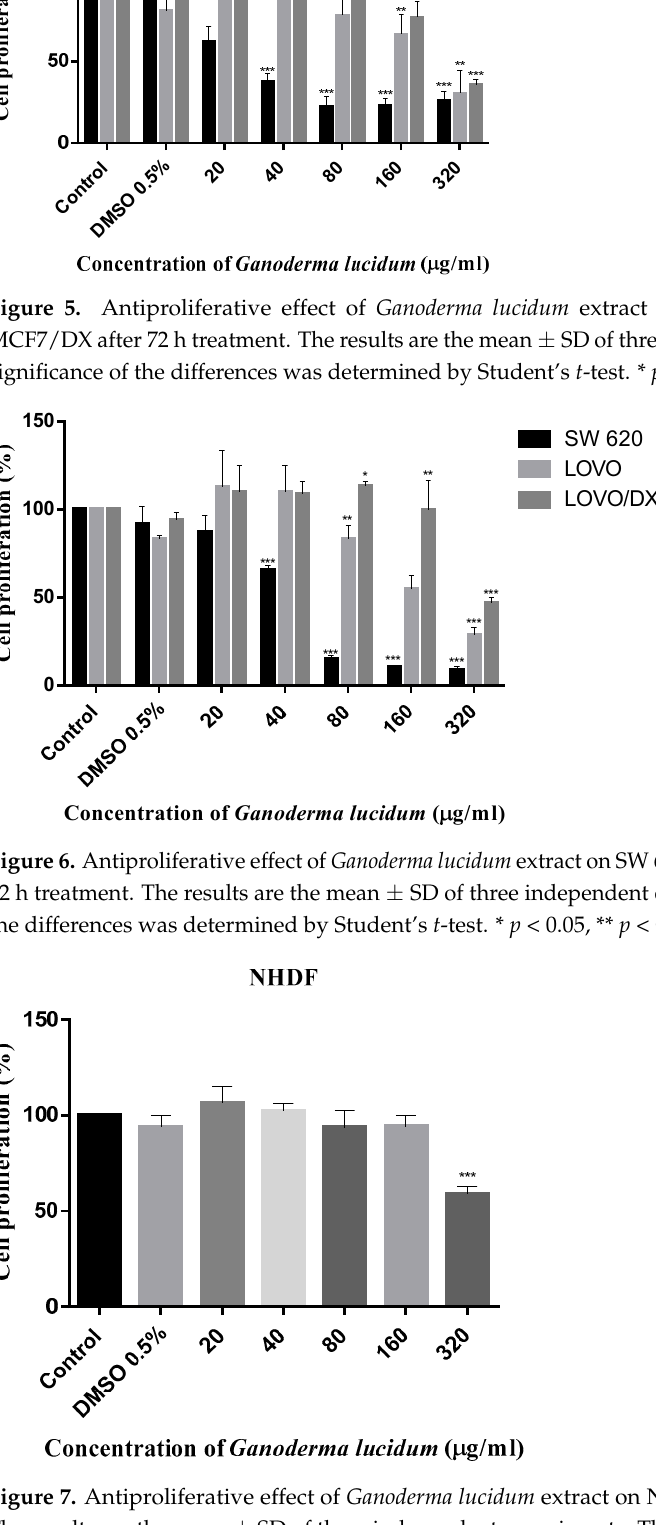
Figure 7. Antiproliferative effect of Ganoderma lucidum extract on NHDF cells after 72 h treatment. The results are the mean ± SD of three independent experiments. The significance of the differences was determined by Student’s t -test. *** p < 0.001. Table 4. Inhibition concentrations (IC 50 ; µg/mL) of Ganoderma lucidum a gainst six cancer cell lines. Values are presented as mean ± SD.